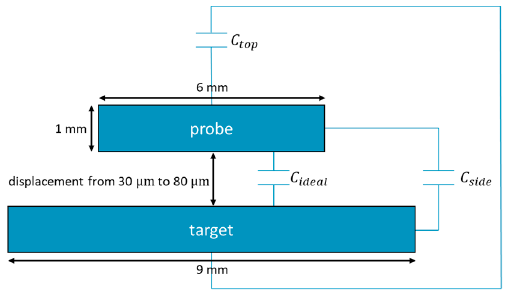
Figure 1. Sketch of the geometry of the initial model. Two discs form a parallel plate capacitor. The dimensions correspond to the geometry of real capacitive sensors. In addition to the capacitance of ideal parallel plate capacitor, the top and side also contribute to the total capacitance.